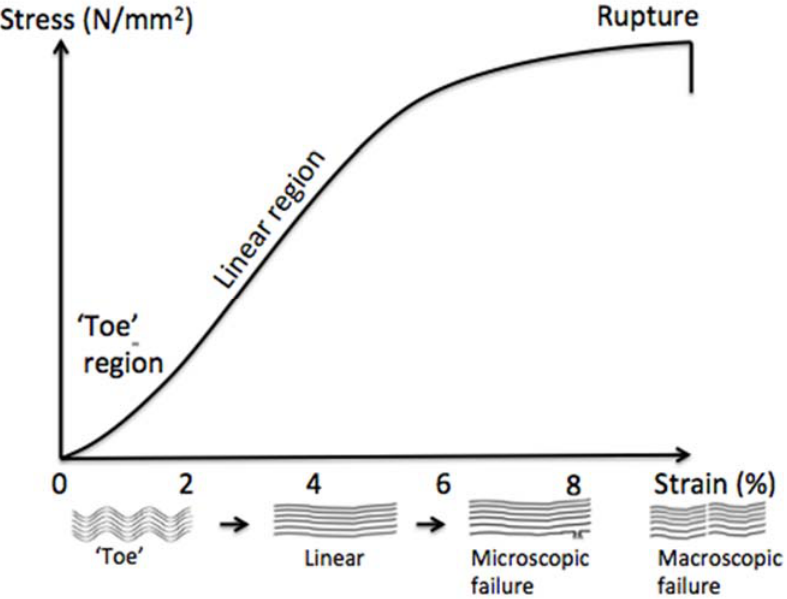
Figure 3. Typical tendon response to stretching at fixed strain rate: stress-strain curve illustrating the various deformations of the collagen fibrils.